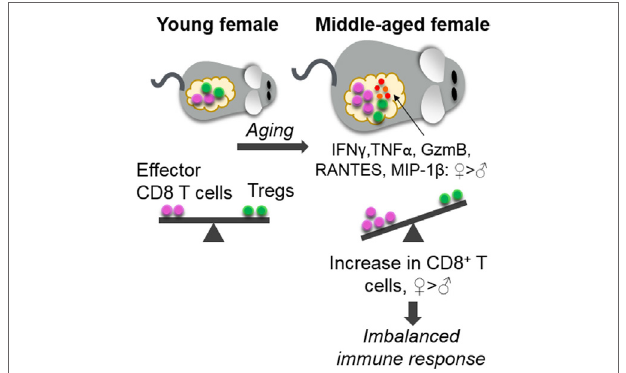
FigUre 5 | Age-associated increase in adipose CD8 + T cells and imbalanced immune response in middle-aged females. Middle-aged females had a greater increase in adipose effector CD8 + T cells than males, without a compensatory increase in anti-inflammatory regulatory T cells (Tregs). Higher levels of the CD8 + T-cell chemokine RANTES, MIP-1 β , and the pro-inflammatory cytokines IFN- γ , TNF- α , and granzyme B (GzmB) were also observed in middle-aged females. We hypothesize that this imbalance may promote a pro-inflammatory milieu and contribute to increased cardiovascular disease burden in aging